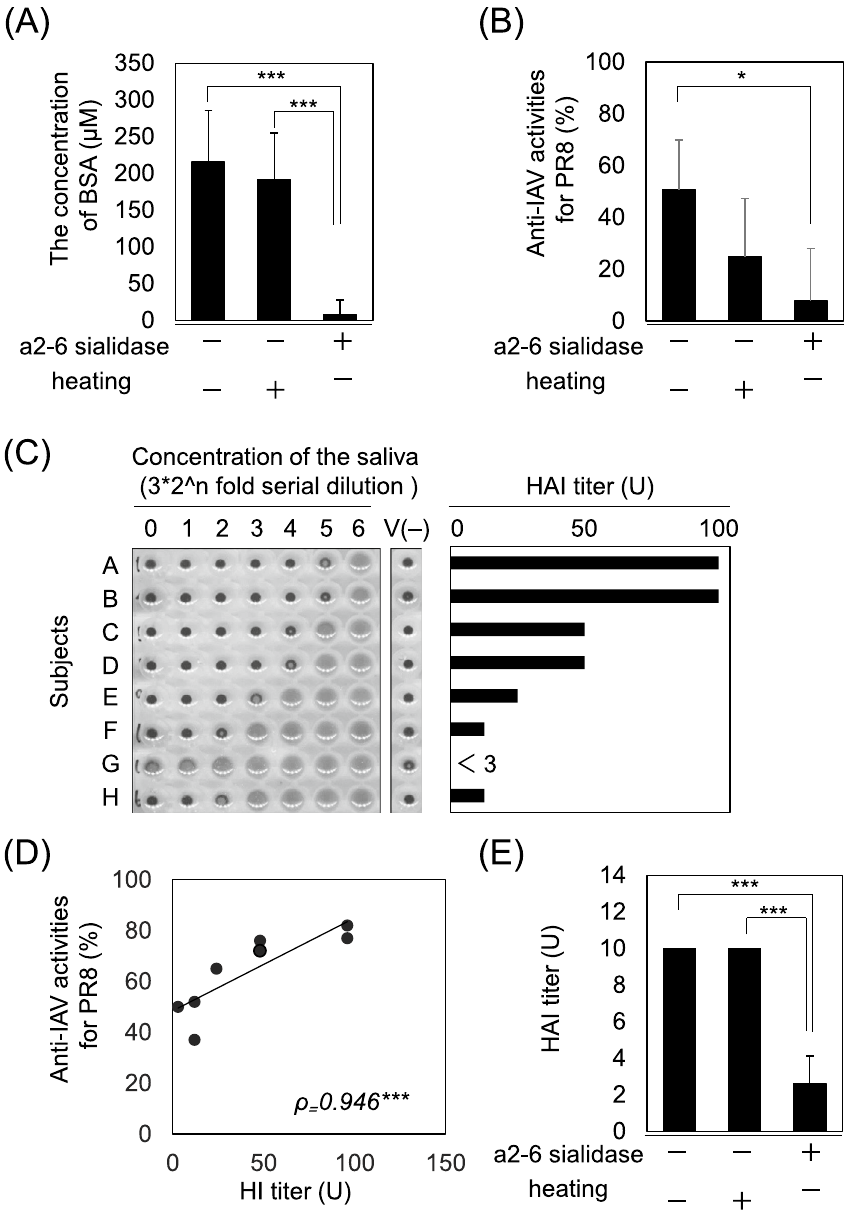
Figure 3. Contribution of protein-bound sialic acid to salivary anti-IAV activity. Effect of α(2-3,6)-sialidase or heat treatment on ( A ) the concentration of BSA and ( B ) salivary anti-IAV activity against the PR8 IAV strain. ( C ) Hemagglutination inhibition assay with saliva (n = 8, A–H). The bar graph shows the HI titers of each subject. This experiment was repeated three times with similar results. ( D ) Correlation between salivary anti-IAV activity against the PR8 IAV strain and the HI titer of saliva. The plot shows a moderately positive correlation. ( E ) The effect of α(2-3,6)-sialidase and heat treatment on the HAI titer of saliva. Data are presented as mean ± SD for each group. Average plateau values were compared using one-way analysis of variance and Tukey’s test. ρ Spearman’s correlation coefficient. * p < 0.05; *** p <